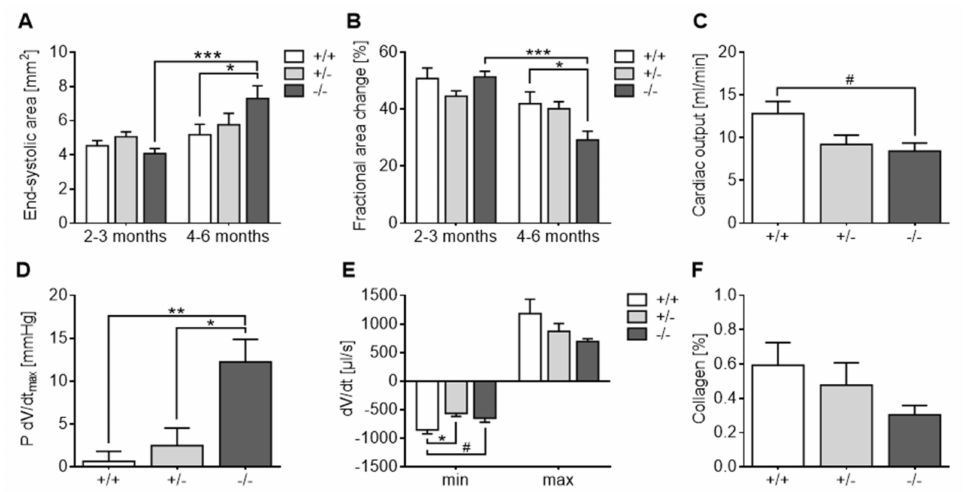
Figure 2. Age-dependent development cardiac dysfunction in 5-HTT deficient ( − / − ) mice. ( A , B ) Echocardiographic assessment of left ventricular dimensions and function revealed a sig- nificant increase in end-systolic area ( A ) and decline in fractional area change ( B ) in 4–6-month-old 5-HTT − / − mice relative to age-matched controls and 2–3-month-old 5-HTT − / − mice ( n = 8–18 per age group and genotype). ( C – E ) Hemodynamic measurements from 7-month-old mice demonstrated slightly diminished cardiac output ( C ), increased pressure at the peak rate of left ventricular filling ( D ) and decreased peak systolic ejection rate ( E ) in 5-HTT − / − mice as compared to 5-HTT+/+ litter- mates ( n = 5–6/genotype). ( F ) Myocardial collagen content did not differ between 5-Htt genotypes ( n = 6/genotype). Data are shown as mean ± standard error of the mean (SEM). # p < 0.1, * p < 0.05, ** p < 0.01 and *** p < 0.001; two-way analysis of variance (ANOVA) followed by Sidak multiple comparisons test ( A , B ) or one-way ANOVA with Tukey post hoc test ( C – F